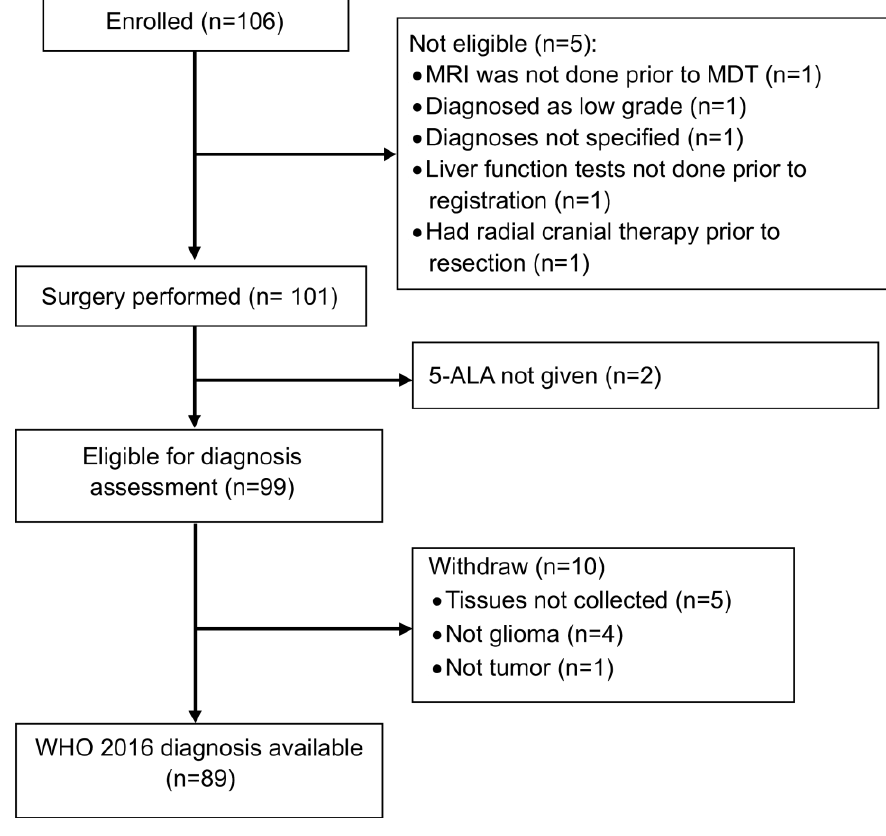
Figure 3. Consort Diagram.